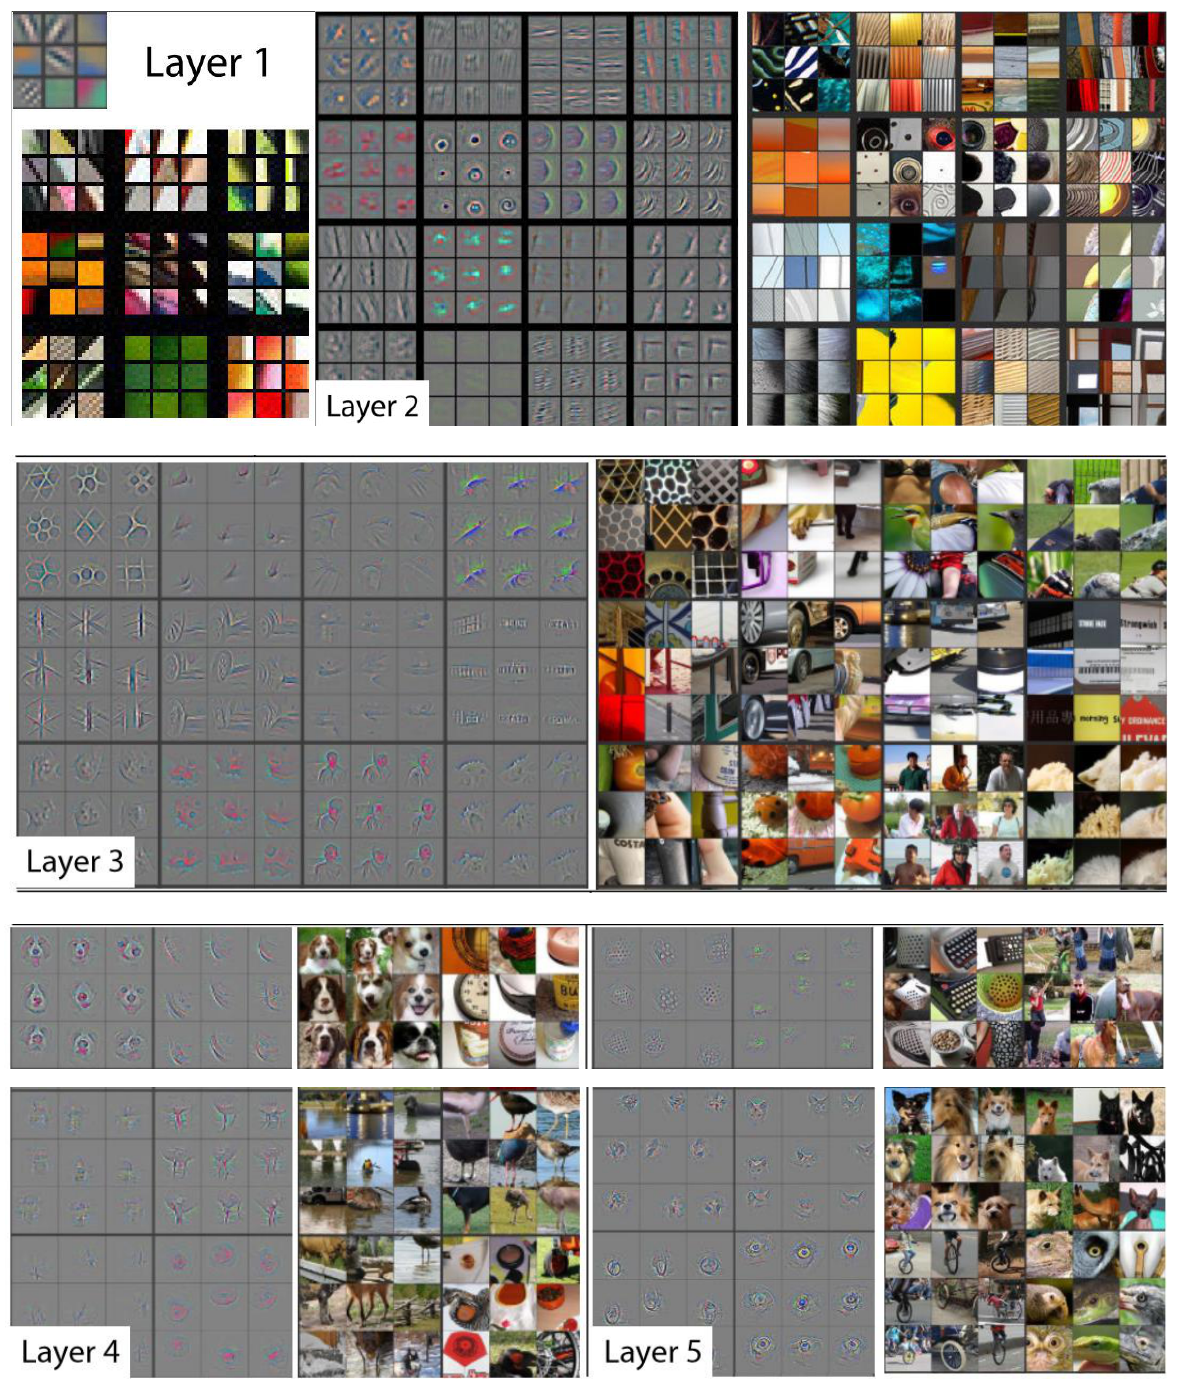
Figure 21. Activations of a convolutional neural network by layers.